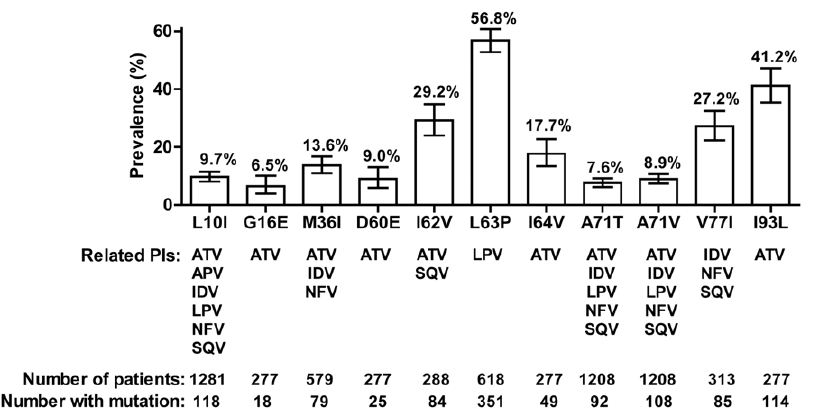
Figure 1. Prevalence of minor protease inhibitor (PI) mutations. Minor PI mutations with a prevalence $ 5% and PI treatments potentially related to these mutations [22]. Error bars represent 95% confidence interval.